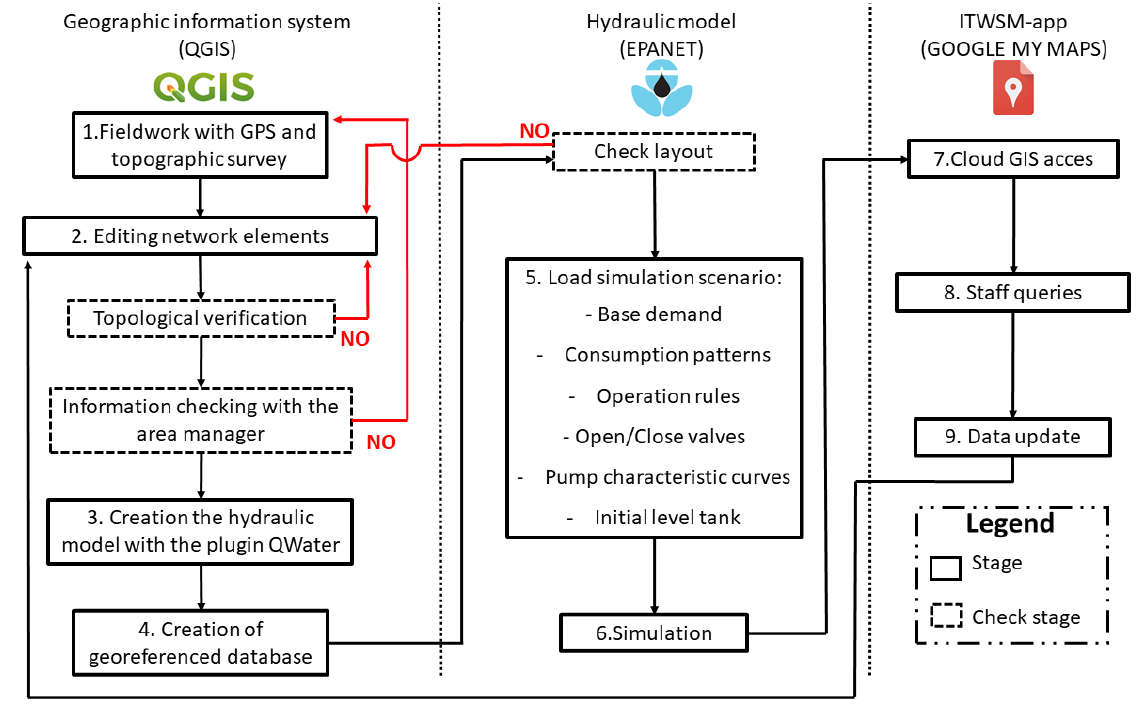
Figure 1. ITWSM flow chart.